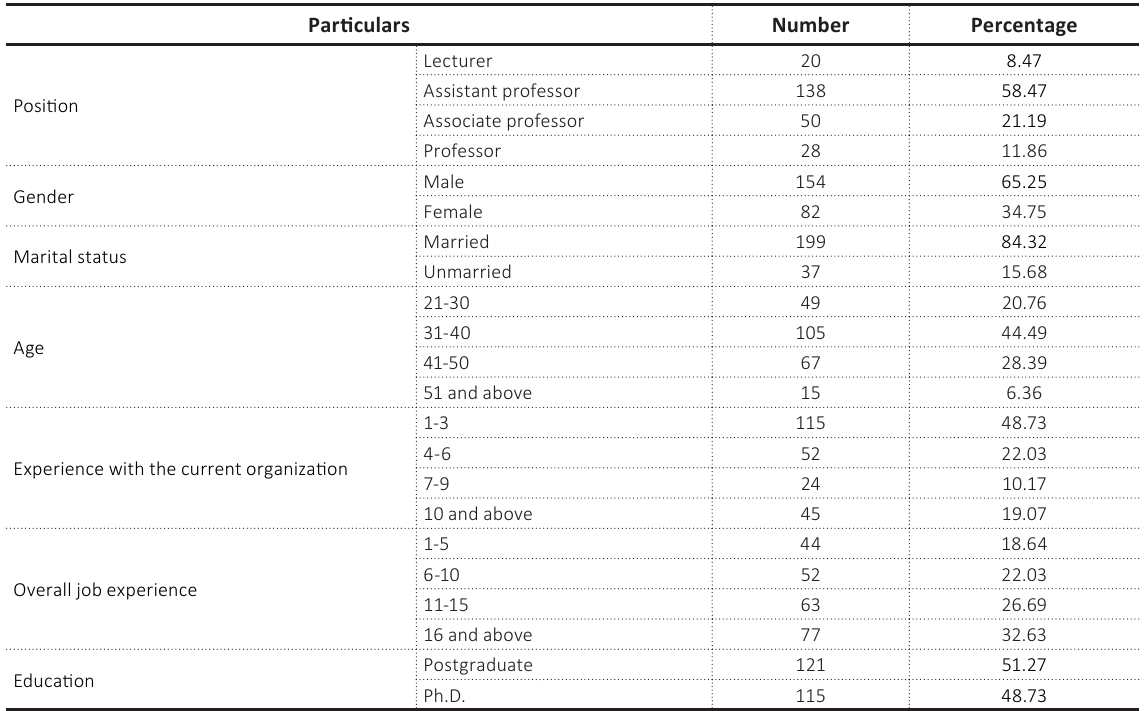
Table 1. Demographics of the sample ( N =